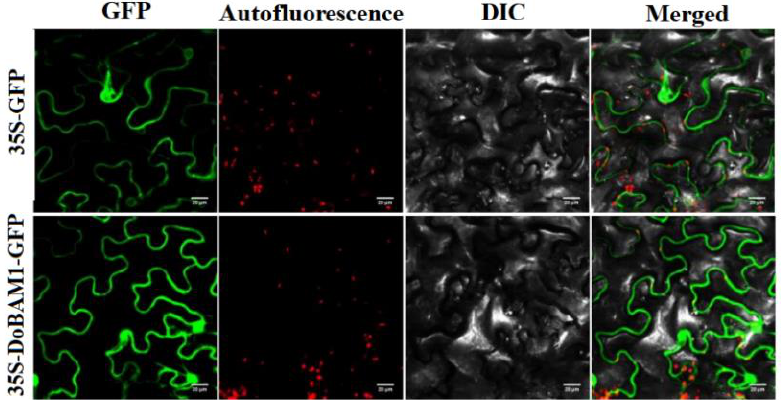
Figure 6. Subcellular localization of the DoBAM1 fusion protein in cells of tobacco leaves. The 4 panels from left to right indicate the GFP fluorescence, chloroplast autofluorescence, bright field, and merged images, respectively. The horizontal scale bar = 20 μM.